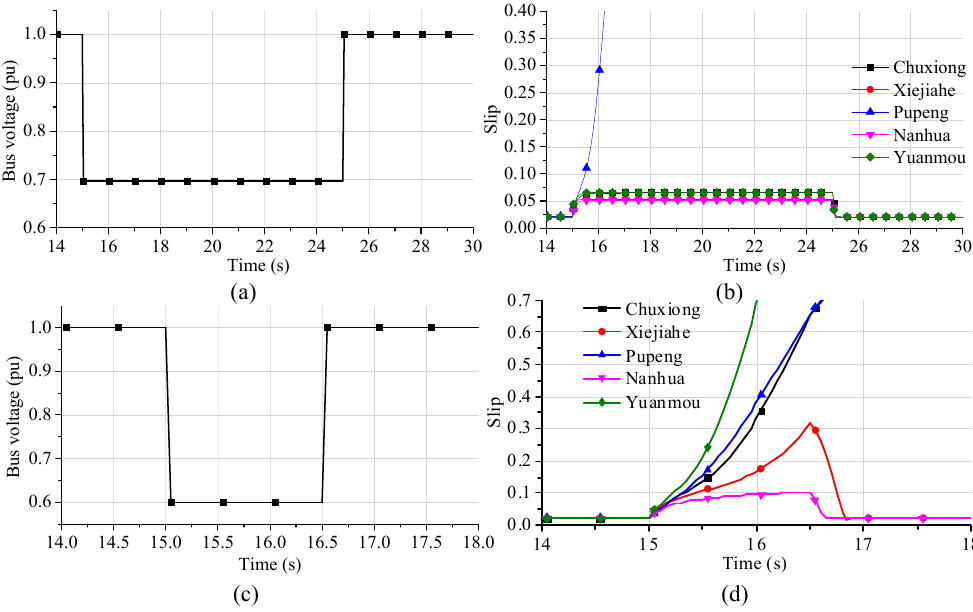
Figure 9. Simulation results to verify the SGCC practical criterion: ( a ) Lucheng bus voltage curve (condition 1); ( b ) motor slip curves (condition 1); ( c ) Lucheng bus voltage curve (condition 2); ( d ) motor slip curves (condition 2).